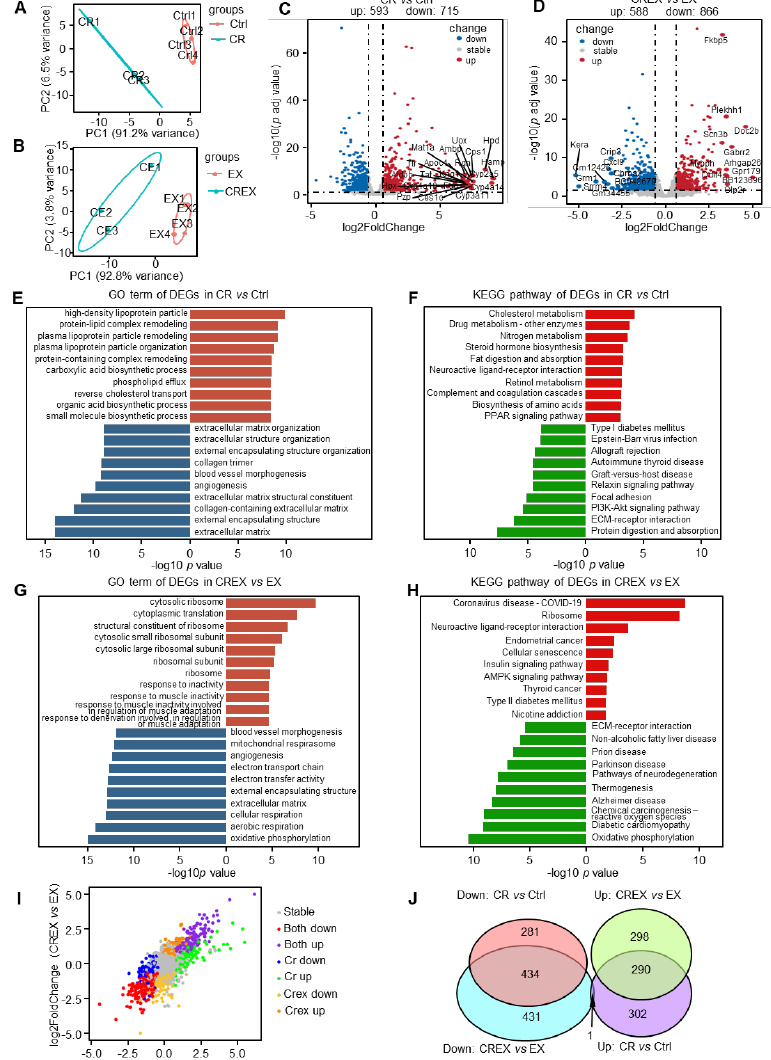
Figure 4. Transcriptomic changes in skeletal muscle upon CR with or without EX. ( A , B ) principal component analysis plot of the skeletal muscle samples in the control and CR groups ( A ) and in the EX and CREX groups ( B ). ( C , D ) Volcano plots of DEGs in the CR vs. control groups ( C ) and in the CREX vs. EX groups ( D ). The top 20 genes with the largest absolute values for log2FC were labeled (down: p < 0.05 and log2FC < −0.58; up: p < 0.05 and log2FC > 0.58). ( E ) Enriched GO terms for all DEGs in the skeletal muscle upon CR. ( F ) Enriched KEGG pathways for all DEGs in the skeletal muscle upon CR. ( G ) Enriched GO terms for all DEGs in the skeletal muscle upon CREX. ( H ) Enriched KEGG pathways for all DEGs in the skeletal muscle upon CREX. ( I ) Dot plot of genes’ log2FC in CR vs. control groups and CREX vs. EX groups. Dots with different colors represent genes in different patterns. Stable, genes that were not differently expressed in the CR vs. control groups or CREX vs. EX groups; Both down, downregulated DEGS across the two comparisons; Both up, upregulated DEGS across the two comparisons; CR down, specific downregulated DEGS in the comparison between the CR and control groups; CR up, upregulated DEGS in the comparison between the CR and control groups; CREX down, specific downregulated DEGS in the comparison between the CREX and EX groups; CREX up, upregulated DEGS in the comparison between the CREX and EX groups. ( J ) Venn plot of common and distinct DEGs upon CR with or without EX. Brick red, enriched GO terms for upregulated DEGs; navy blue, enriched GO terms for downregulated DEGs; bright red, enriched KEGG pathways for upregulated DEGs; green, enriched KEGG pathways for downregulated